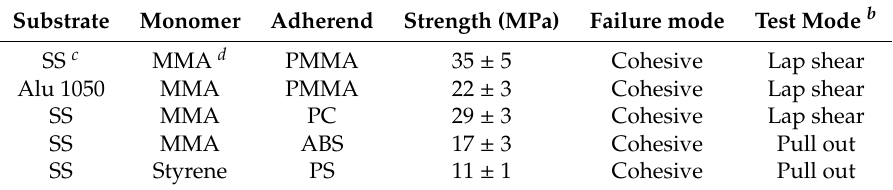
Table 2. Various material combinations with bonding relying on the entanglement of polymer brushes into bulk polymers a .